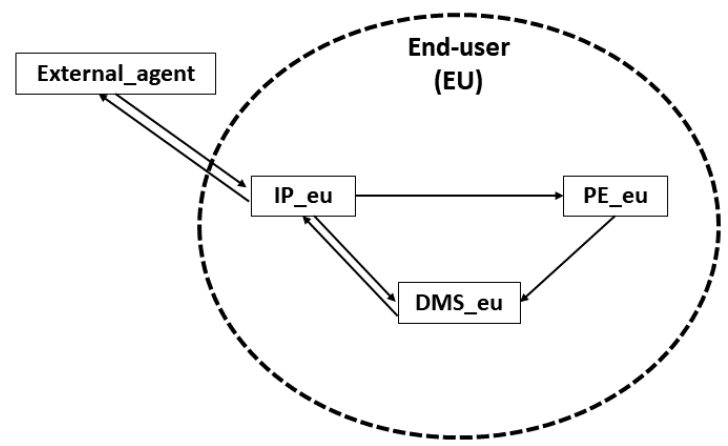
Figure 1. Organization of end-user agents.